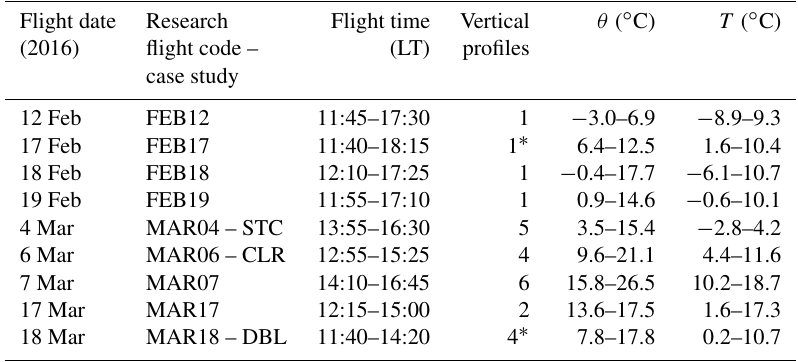
Table 1. Flight date, research flight code, flight time (local time, LT), number of vertical profiles conducted, and the observed range of potential temperature ( θ ) and ambient temperature ( T ) during the flights.